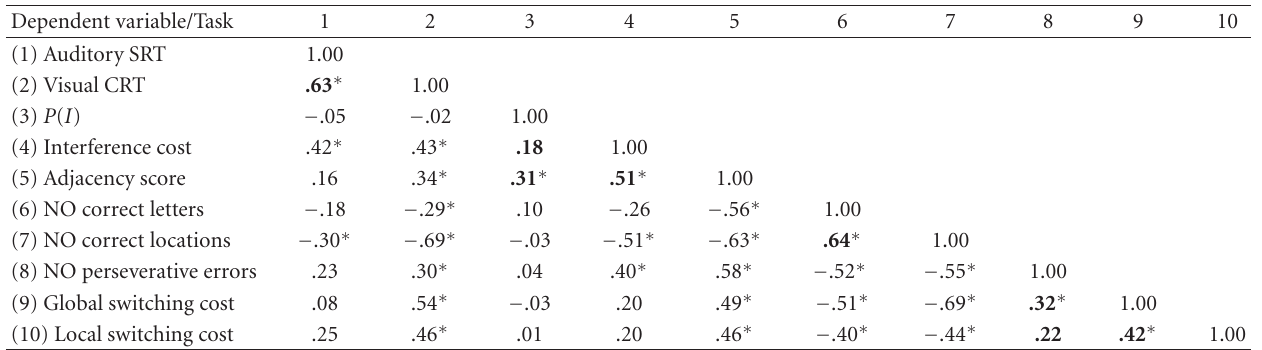
Table 2: Matrix of correlations between the indices of cognitive performance, one index per cognitive task, for the whole sample. Dependent